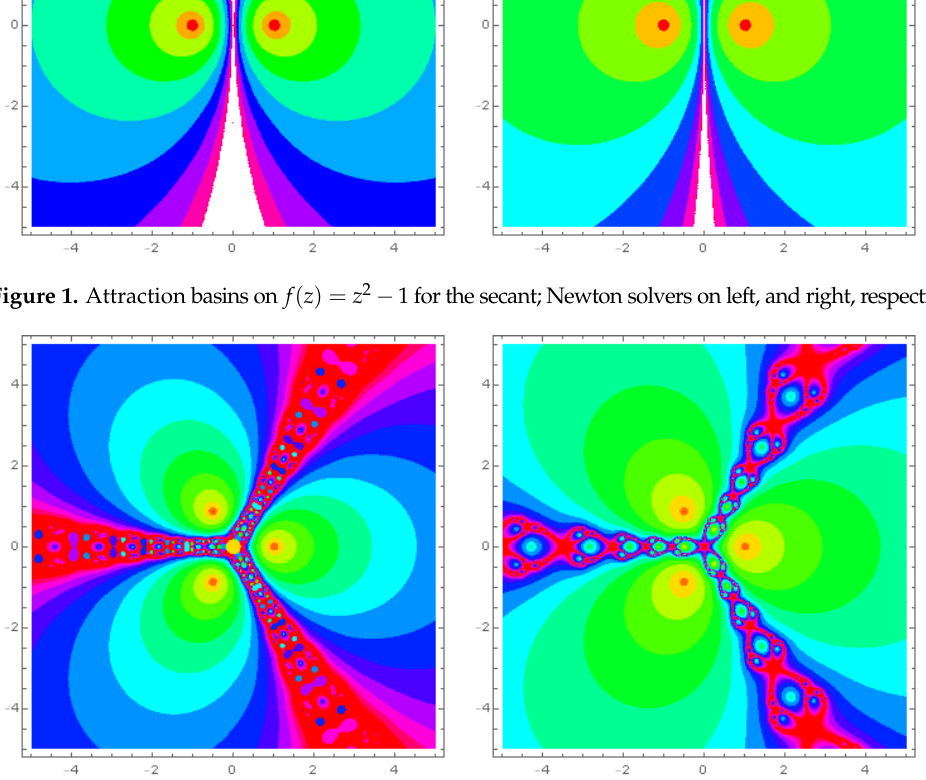
Figure 2. Attraction basins on f ( z ) = z 3 − 1 for the secant; Newton solvers on left and right,